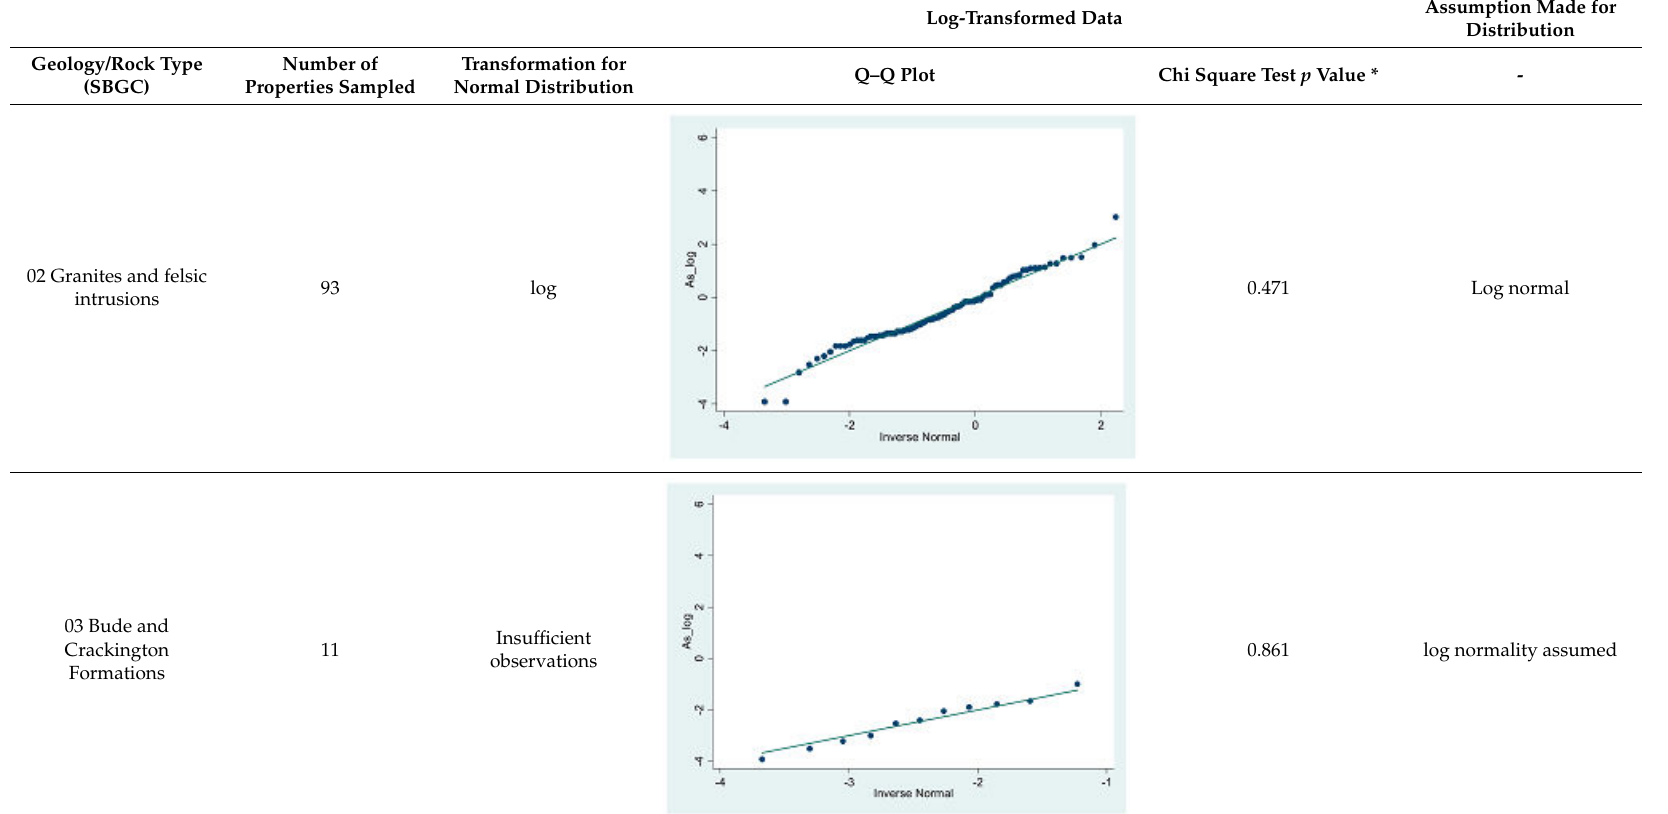
Table A1. Summary of arsenic concentration distributions per Simplified Bedrock Geological Classification (SBGC); exploring distributions, log-normality and